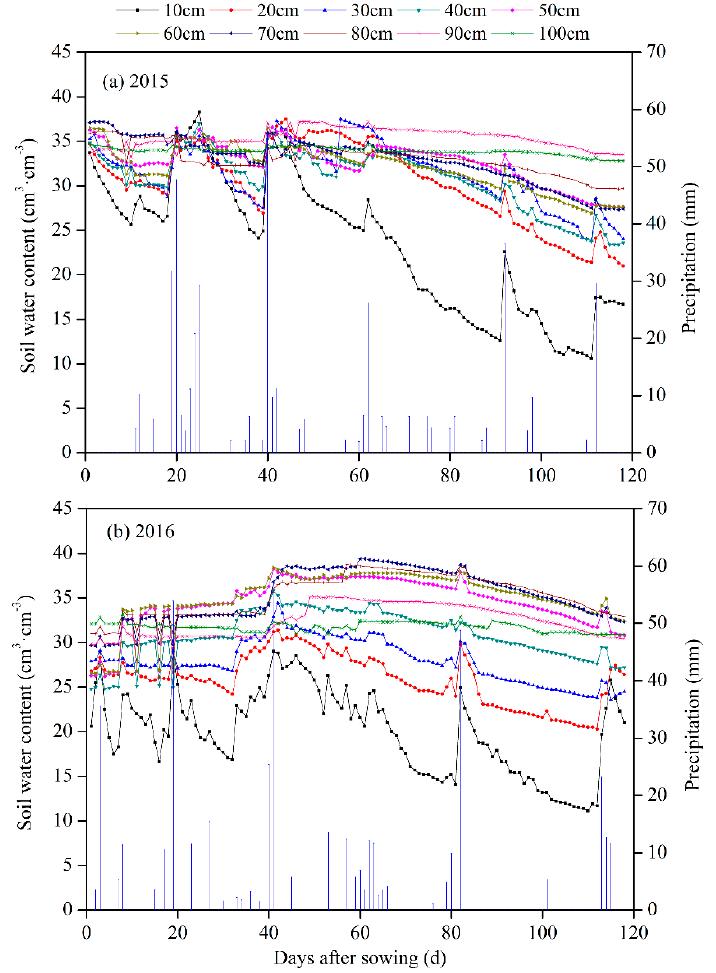
Figure 4. Seasonal variations in soil water content (cm 3 · cm − 3 ) at 10 cm interval to a depth of 100 cm measured by Insentek sensors during maize growing seasons of ( a ) 2015 and ( b ) 2016. Vertical drop lines represent daily precipitation.